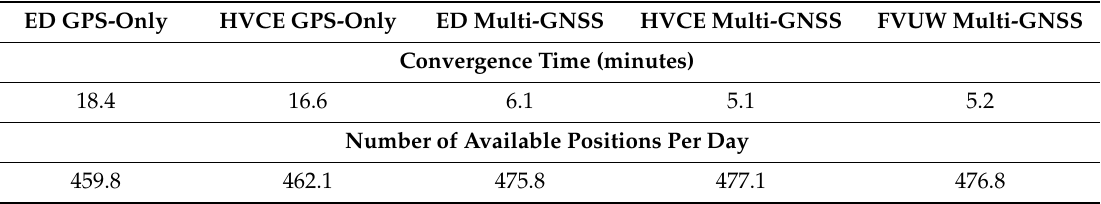
Table 2. Averaged convergence time and number of available positions per day for five strategies. ED GPS-Only